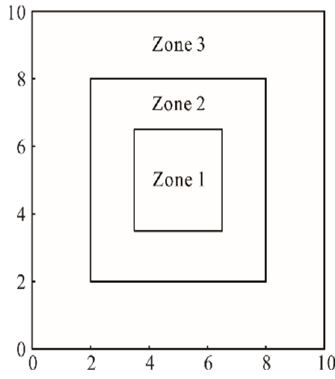
Figure 2. Illustration of speed zones.